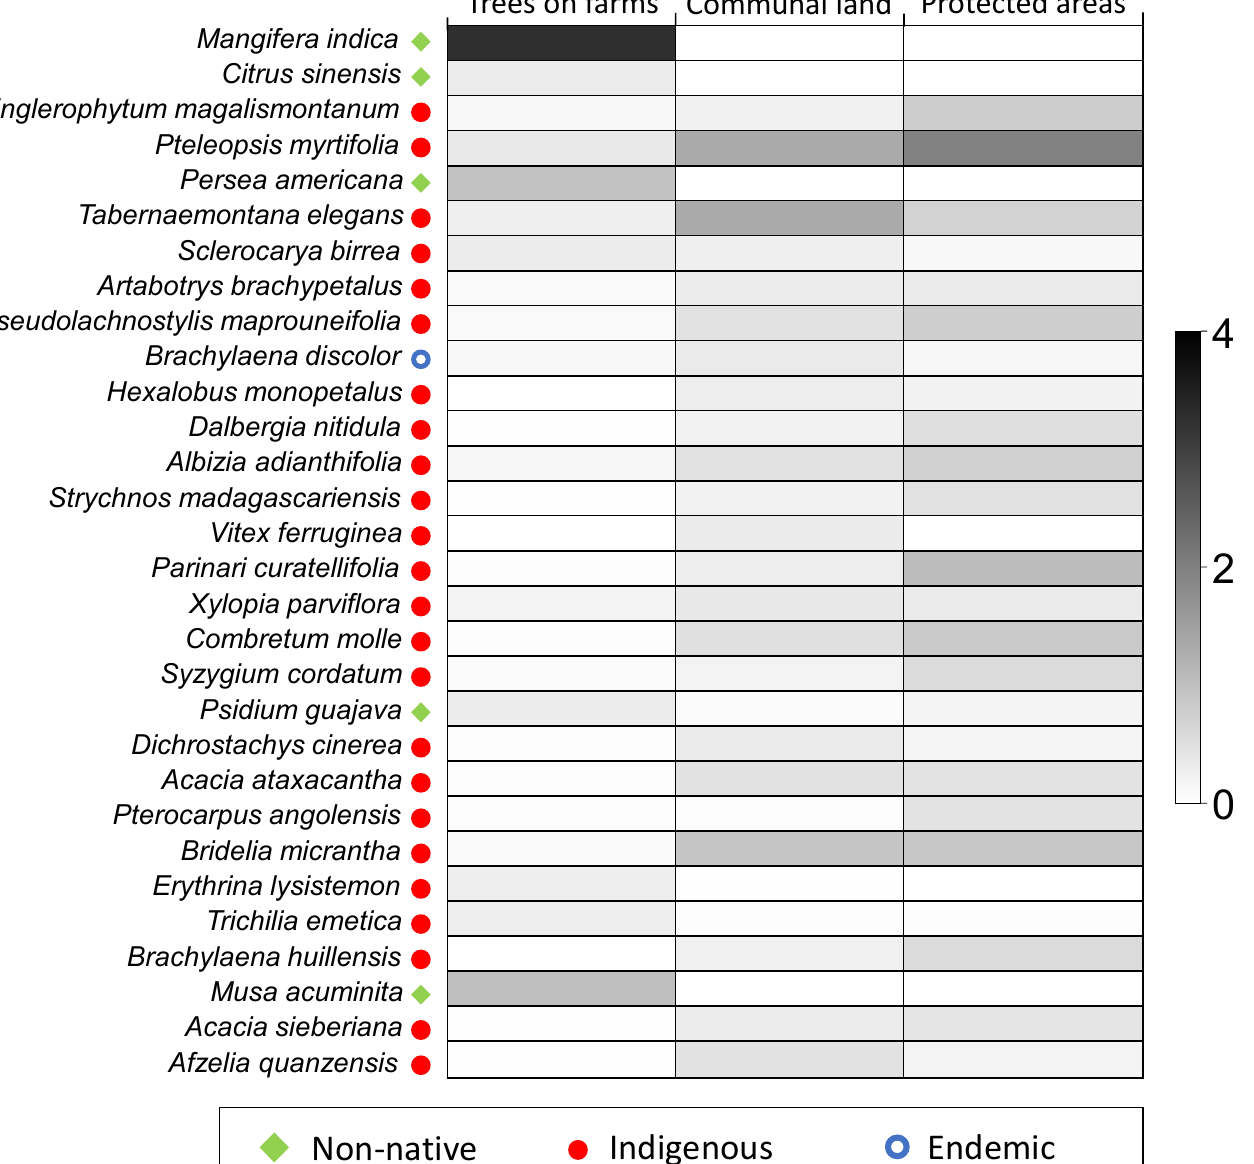
Figure 6. Shade plot showing tree species distribution between land-uses, further subdivided by native or non-native status in South Africa. Overall, in the FGDs sessions, three themes (national conservation policy, commu- nity conservation policy and conservation practices) were selected for an in-depth under- standing of the conservation